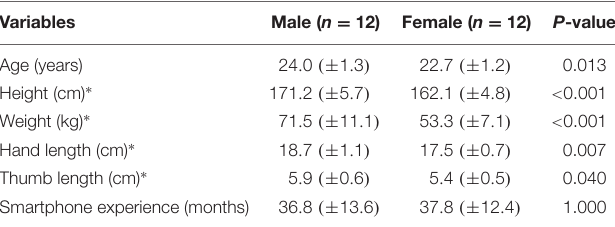
TABLE 1 | Participant demographic characteristics and smartphone